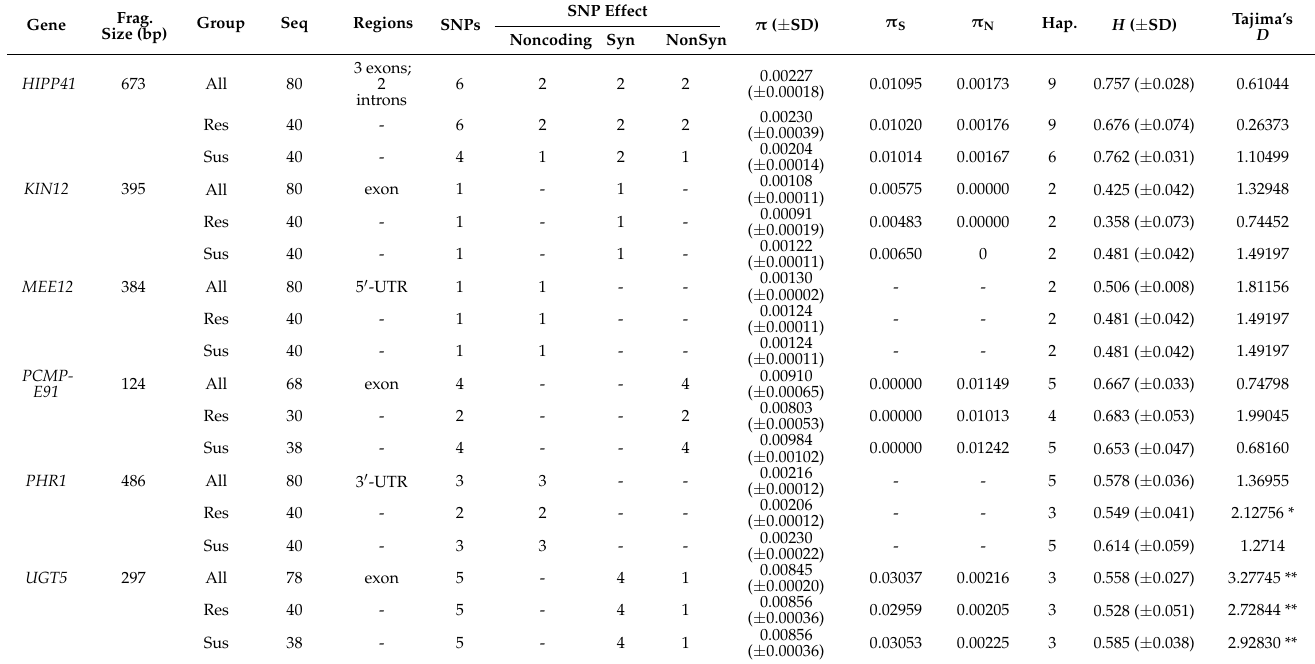
Table 3. Summary of genetic diversity estimates for the six sequenced gene fragments.